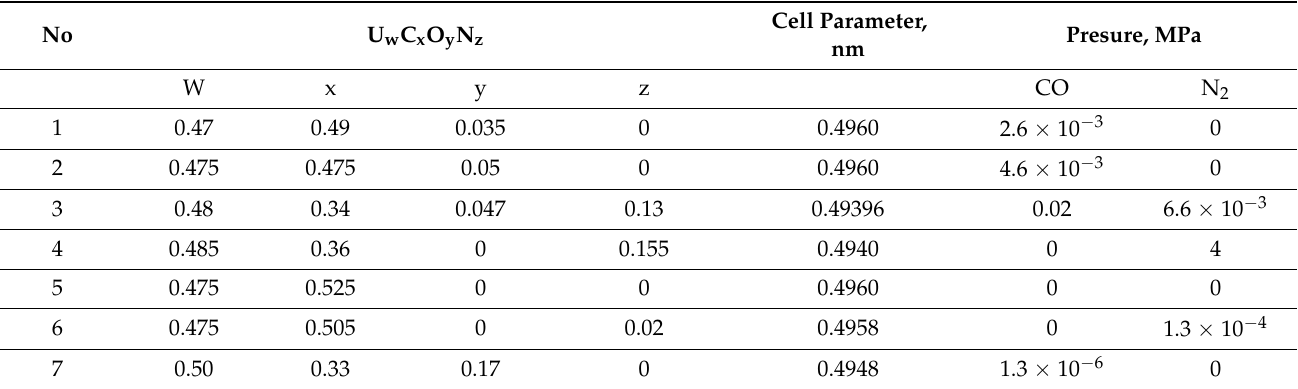
Table 1. Composition, cubic lattice period, and equilibrium pressures CO and N 2 over the U-C-N-O system at 2000 K